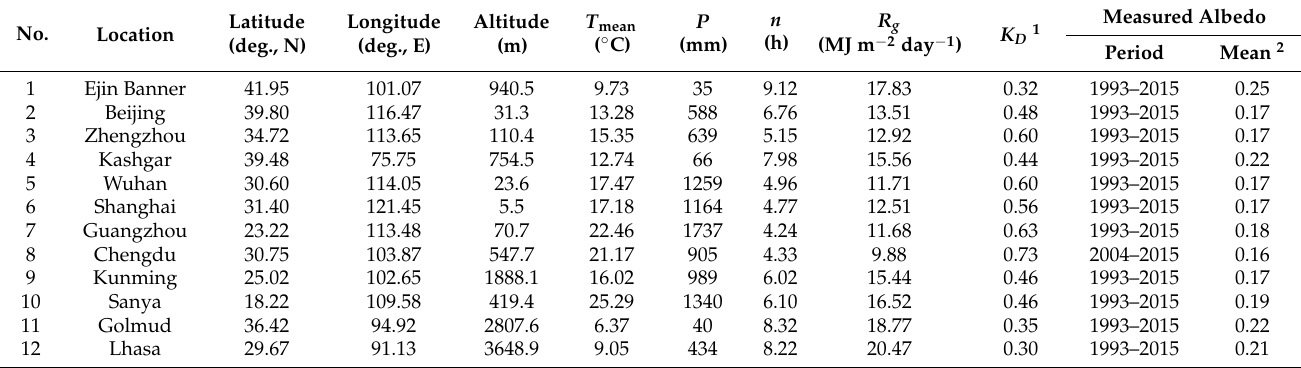
Table 1. Geographical locations and datasets of the 12 stations used in this study.